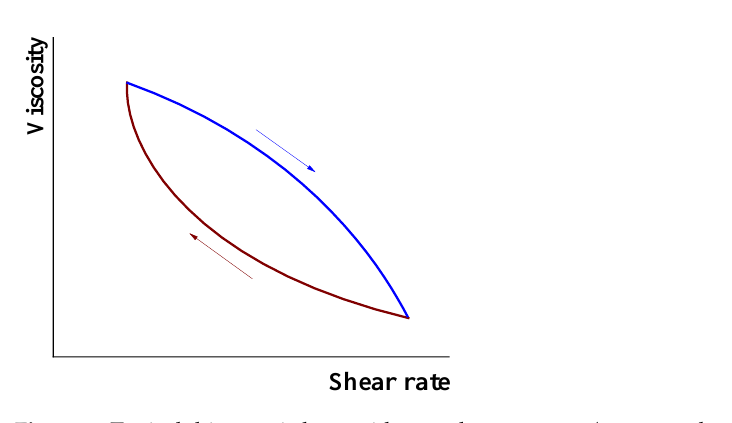
Figure 6. Typical thixotropic loop with complete recovery (return to the starting point).